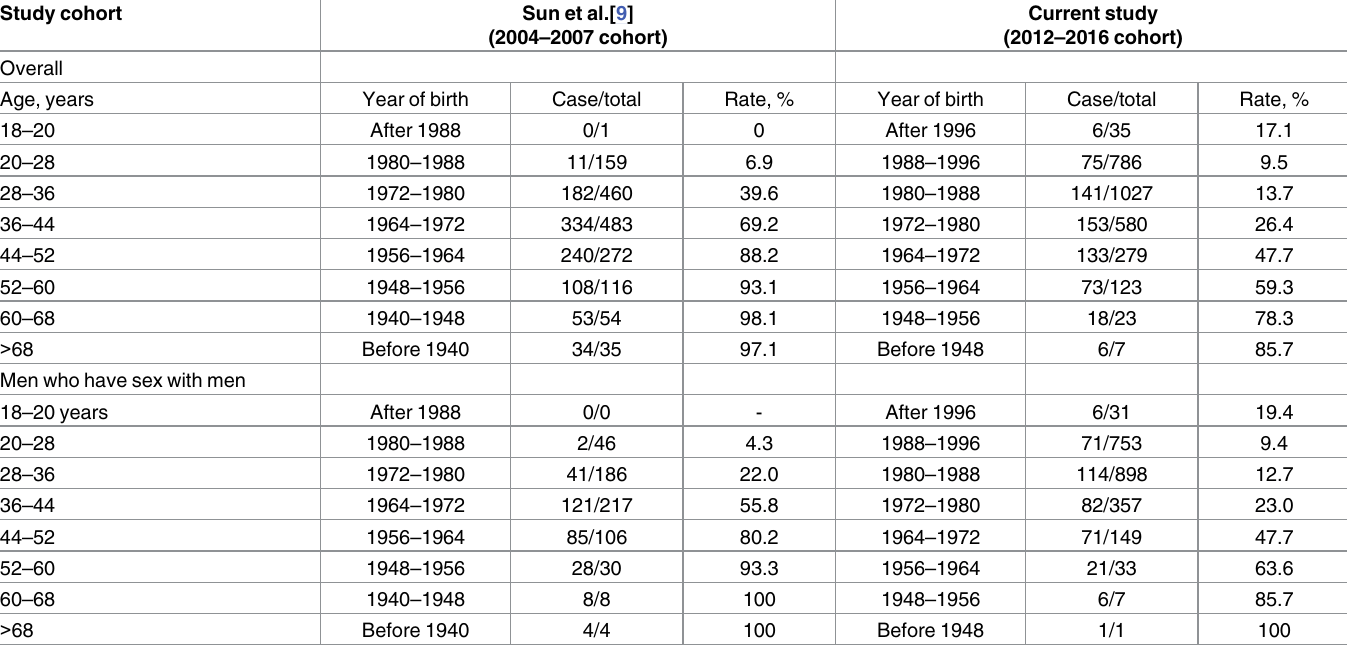
Table 3. Comparisons of hepatitis A seroprevalenceby age and birth year between the 2004–2007cohort and the